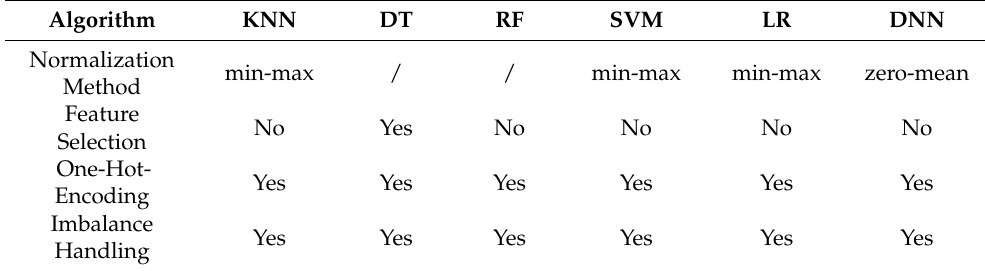
Table 3. Pre-processing methods of different